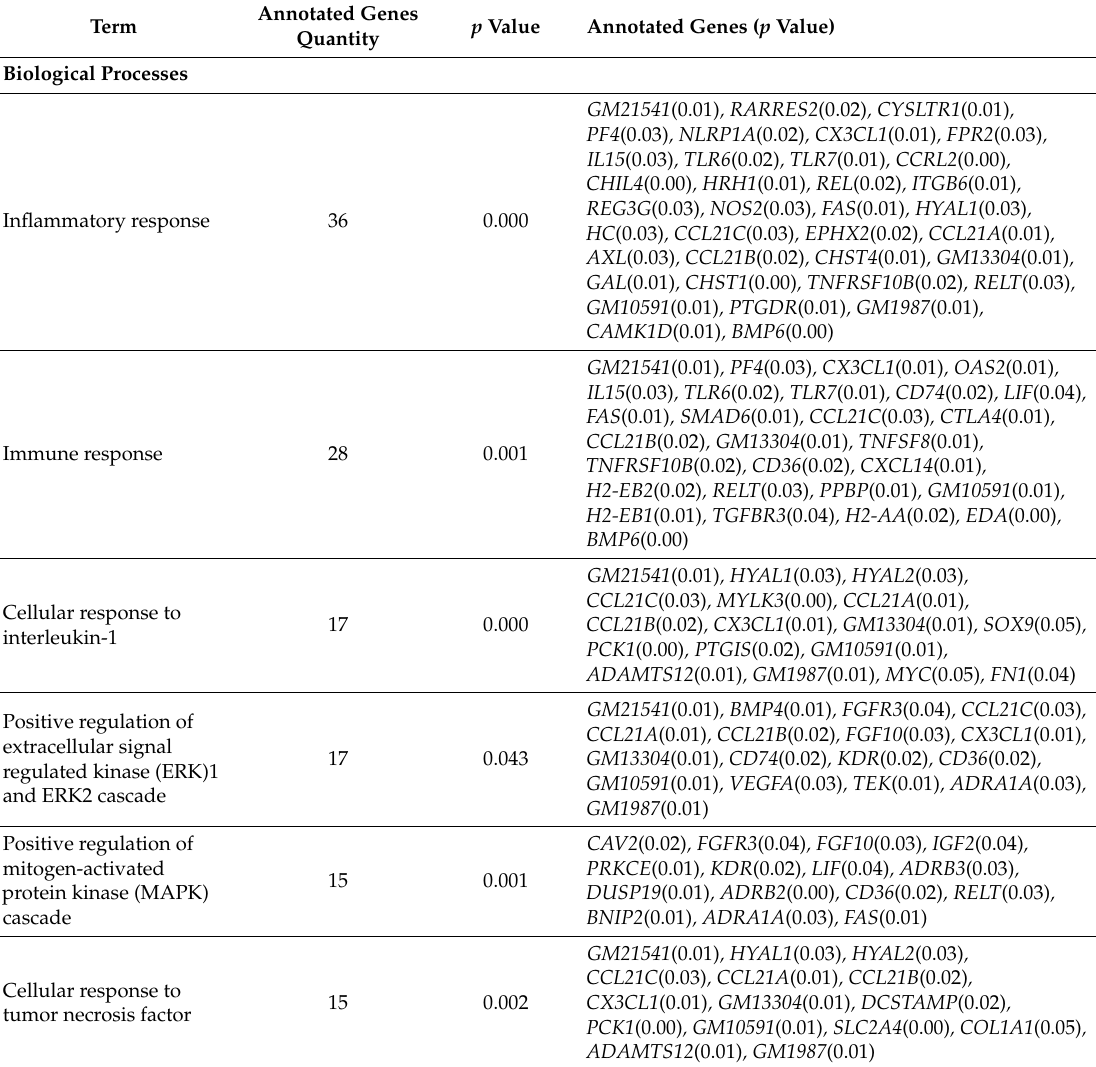
Table 1. Gene ontology (GO) functional category analysis of Kathon-altered